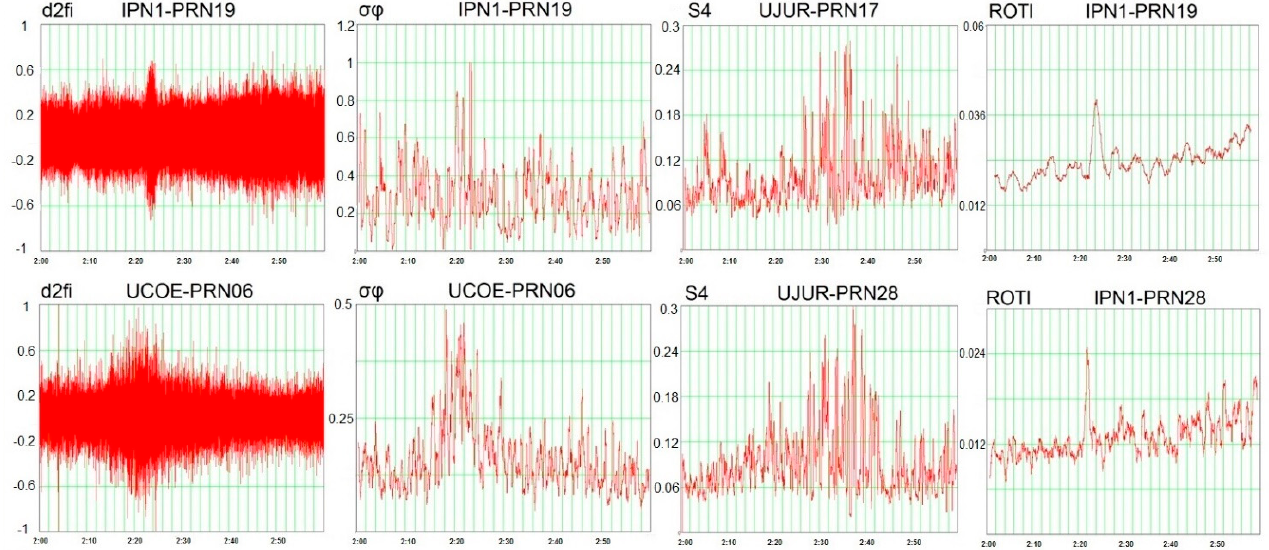
Figure 11. Examples of index bursts at different satellite-receiver rays after the meteoroid flight and explosion.